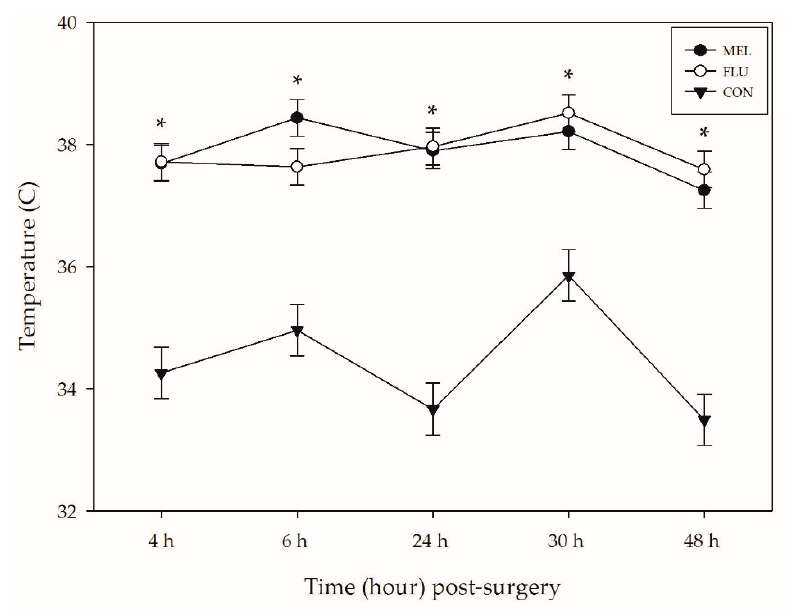
Figure 2. Mean infrared thermography temperature ( ◦ C ± SEM) of the tissues around the abdominal